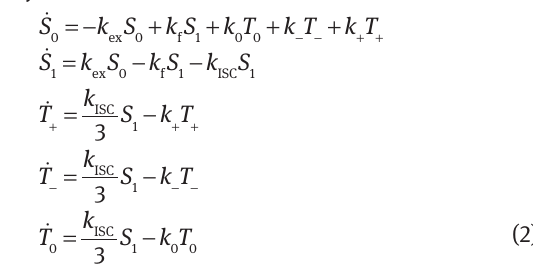
Figure 3B, and polarometry, Figure 3C, to show that the centers have their major spin axis and dipole moment